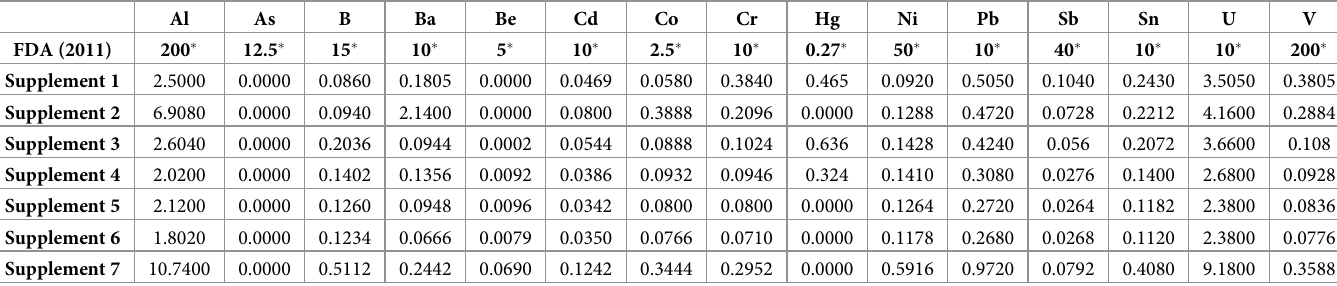
Table 3. Concentrations of toxic metals from the supplements analyzed in the final product (homemade food) in mg/kg of dry matter.